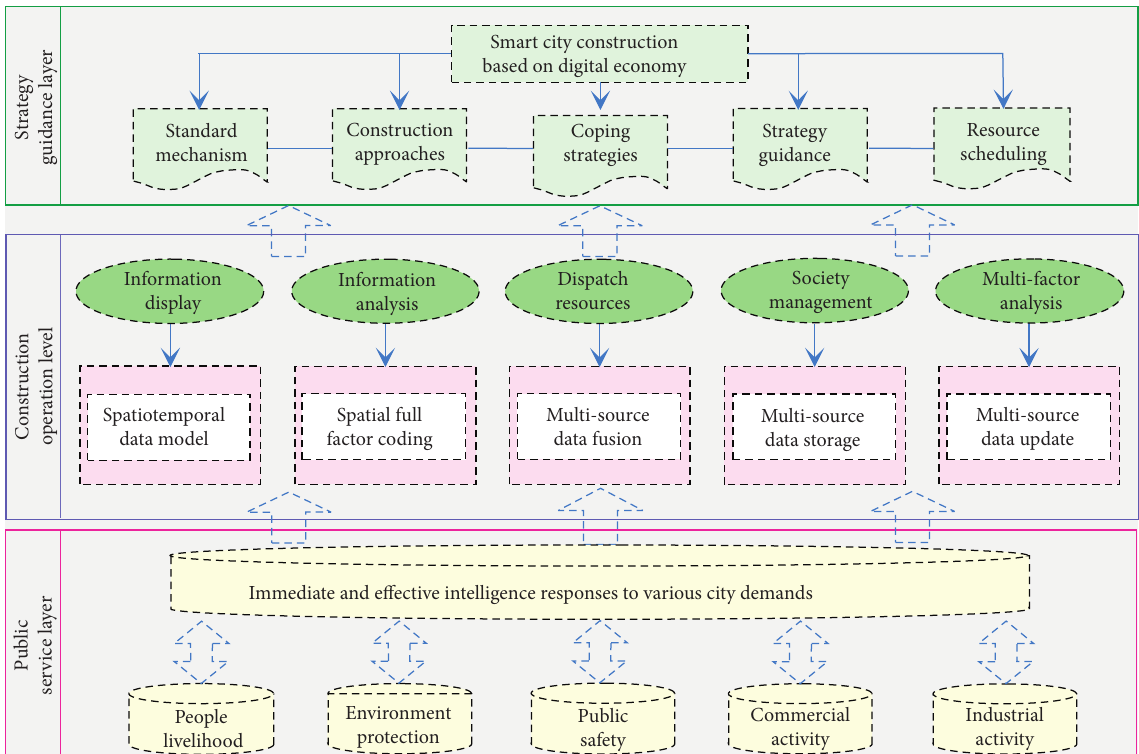
Figure 1: Framework of resource scheduling of smart city under the background of digital